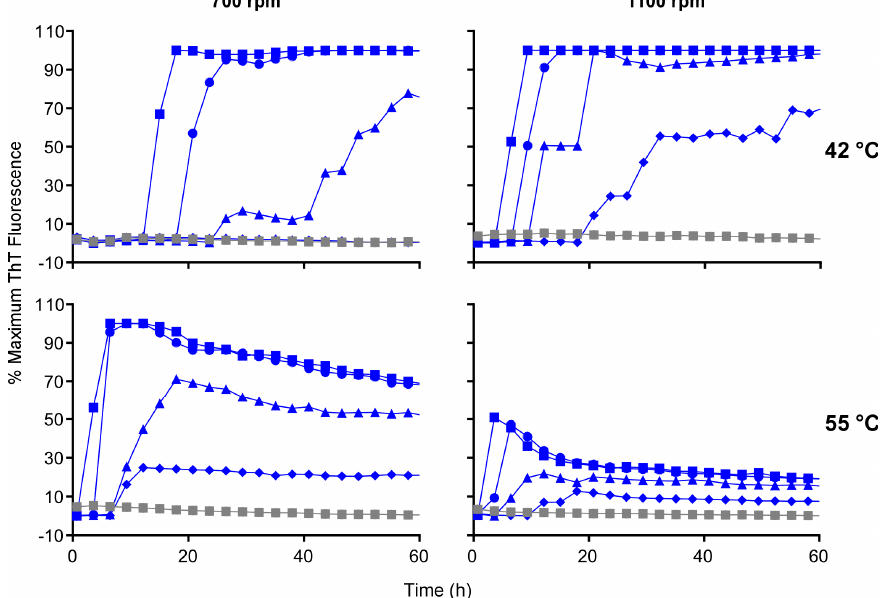
Figure 6. Effects of temperature in combination with different double orbital shaking intensities on RT-QuIC sensitivity. Quadruplicate RT-QuIC reactions were seeded with 2 μ L of scrapie positive (263K) brain tissue dilutions of 5 × 10 − 7 ( ), 5 × 10 − 8 ( ), 5 × 10 − 9 ( ▲ ), and 5 × 10 − 10 ( ) or uninfected hamster brain tissue at a dilution of 5 × 10 − 7 (gray) using N-terminally truncated (residues 90–231) Ha rPrP Sen as substrate. Each trace represents the average ThT signal of quadruplicate wells seeded with the same indicated brain homogenate dilution. The reactions were incubate at 42 °C or 55 °C and subjected to 700 or 1100 rpm double orbital shaking, as indicated. Although ThT readings were taken every 45 min, for visual clarity, the curves report only readings at 135-min intervals.